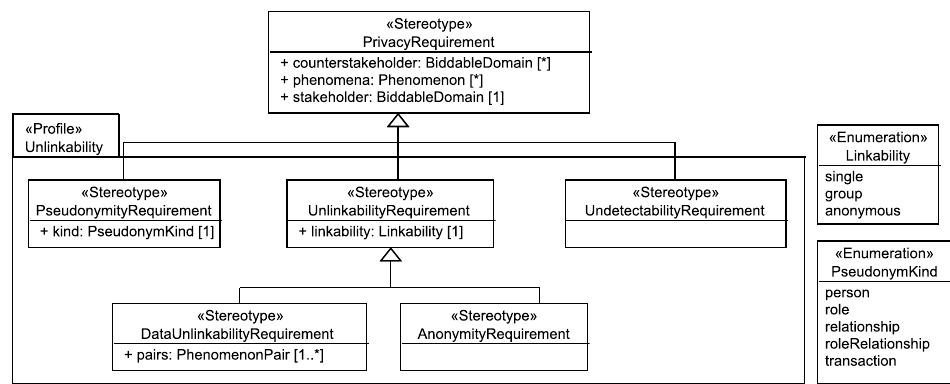
Figure 10. Used Taxonomy of Unlinkability